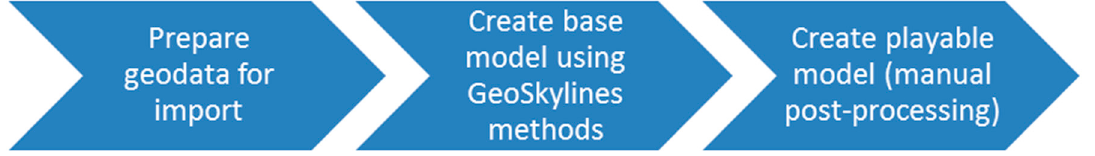
Figure 2. Stages of creating a model of a real-world place in Cities: Skylines using GeoSkylines methods.